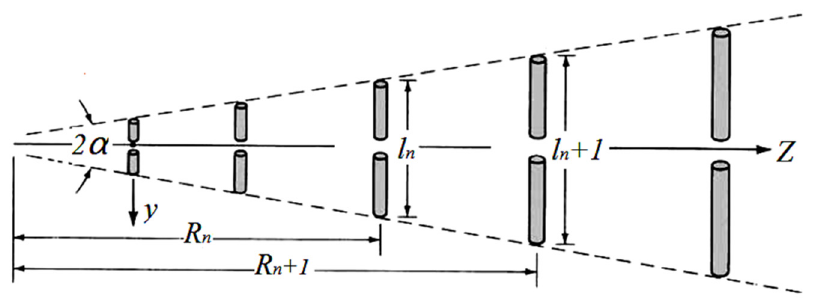
Figure 3. The log-periodic dipole array.